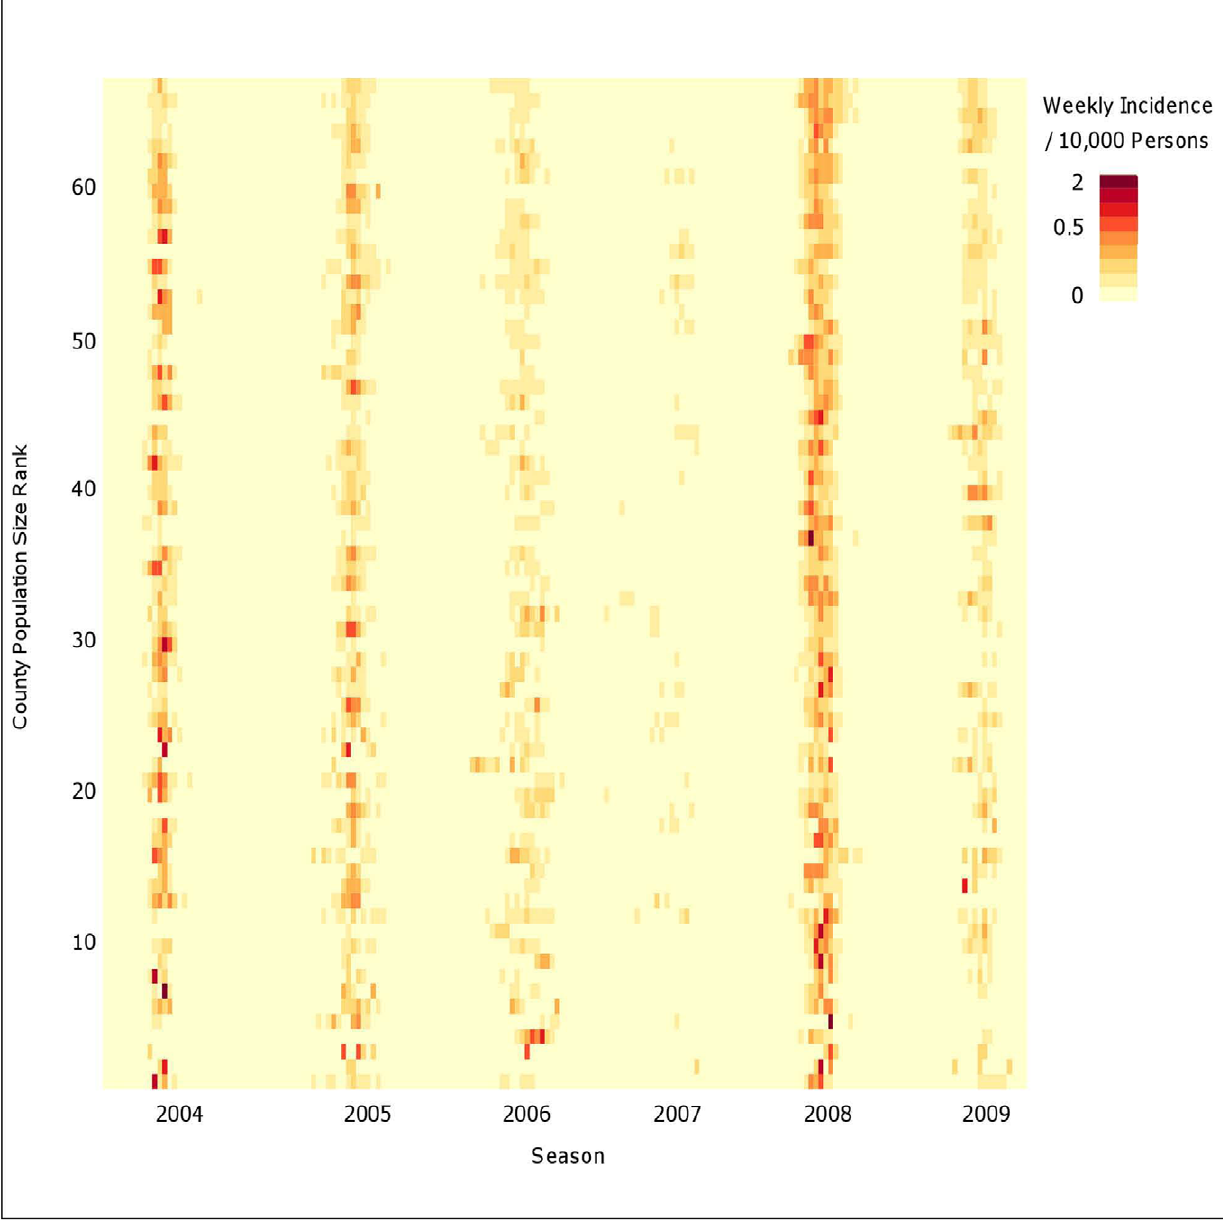
Figure 2. Weekly case incidence for 67 counties by population size. Intensity image displace weekly case incidence (per 10,000 persons) sorted by population size. The counties are arranged from largest population size (67=Philadelphia) to the smallest population size (1=Forest). The surveillance system defines each influenza season to begin in the 40 th week of the calendar year through the last week of April of the following year.